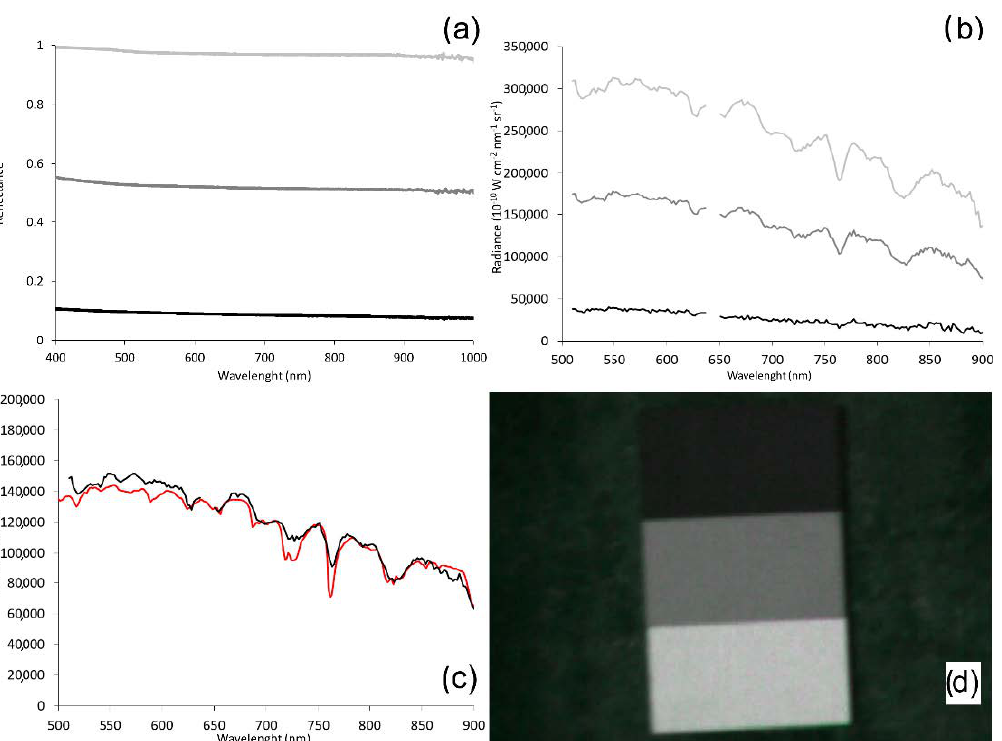
Figure 9. ( a ) Reflectance spectral signature from 400 nm to 1000 nm of the control targets (OptoPolymer panels) obtained in the field with the spectroradiometer (GER); ( b ) Radiance spectral signature of the control targets (OptoPolymer panels) obtained in the field with Senop HSC-2; ( c ) Irradiance spectral signature (DN) comparison between GER spectroradiometer (red line) and Senop HSC-2 (black line); ( d ) OptoPolymer reference panels in the field. Reference panels legend: white panel @ 97% reflectance (light grey line), grey panel 56% reflectance (dark grey line), black panel @ 10% reflectance (black line).